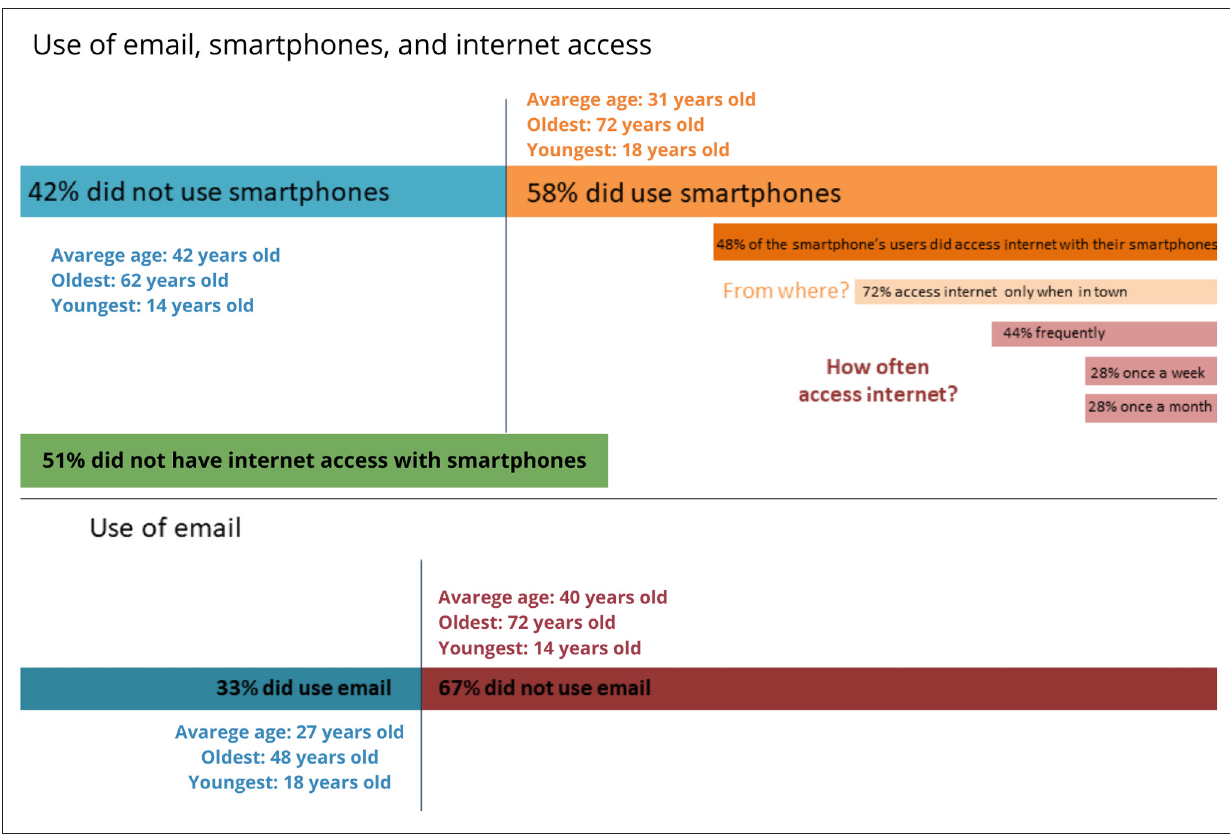
Figure 2 Use of email, smartphones, and internet access, related to participants’ average